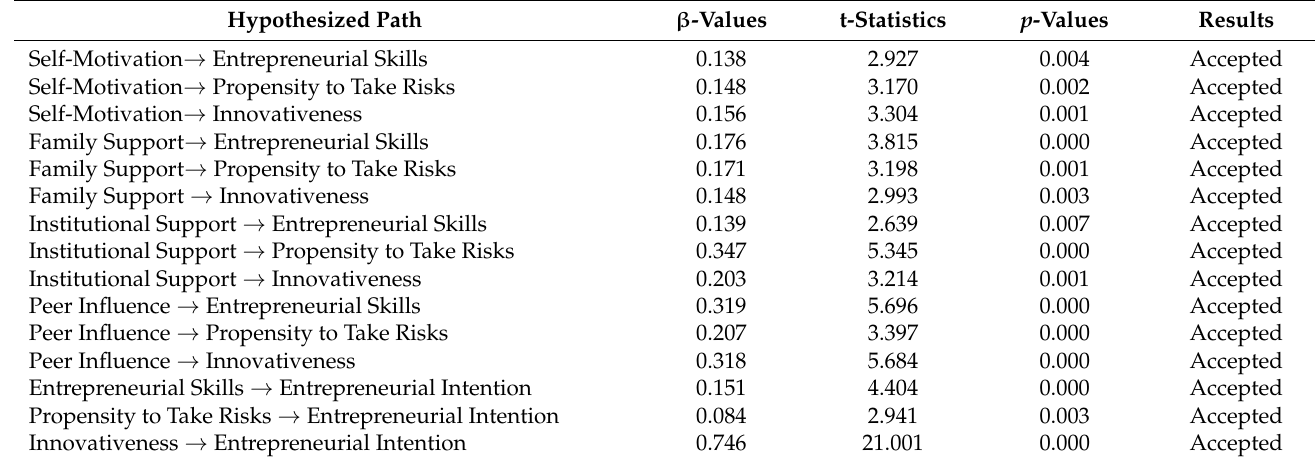
Figure 2. Valid estimation model. Table 4. Direct